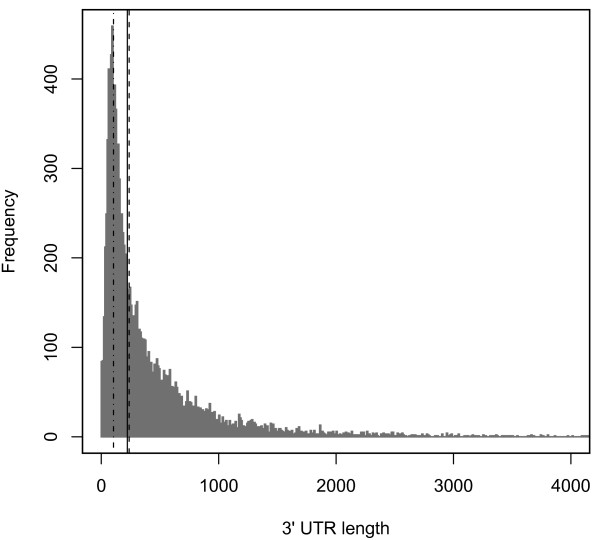
Distribution of 3' UTR length in D. melanogaster. Histogram of the lengths of annotated 3' UTRs in D. melanogaster. The solid black line is the median of the distribution; the dashed line is the median length of expressed regions in D. melanogaster; and the dot-dashed line is the median length of expressed regions in D. virilis.